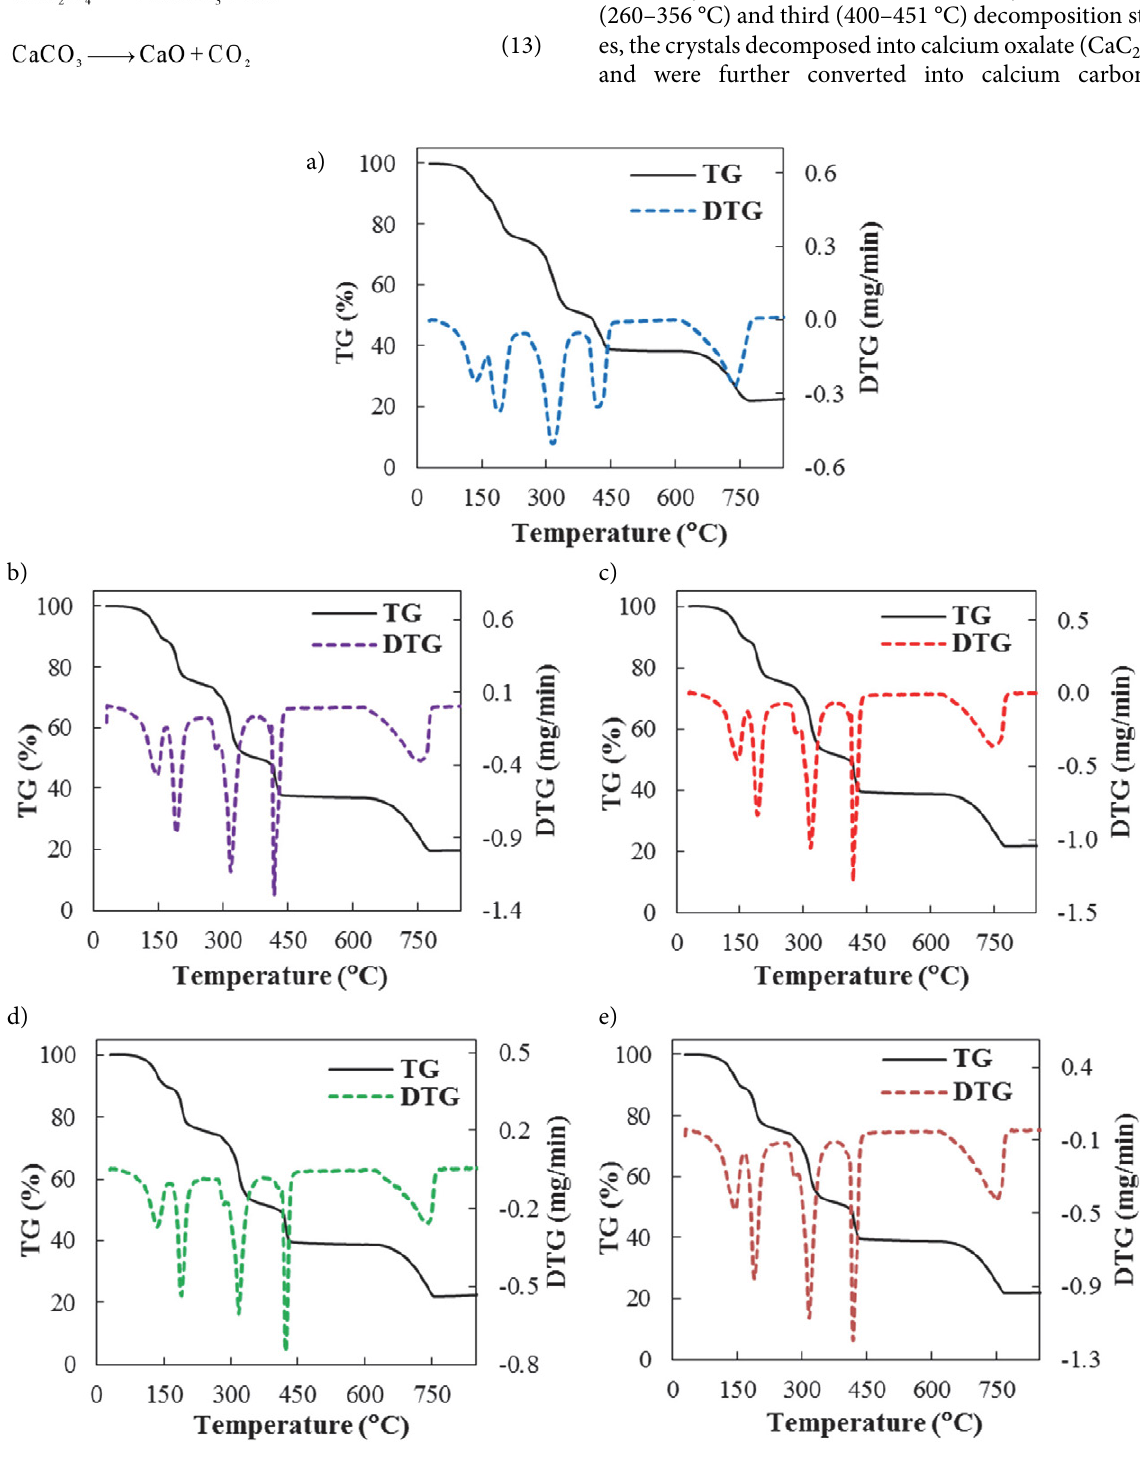
Figure 7. TG/DTG curves of the CTT crystals obtained in pure media (a) and media supplemented with serine (b), alanine (c), methionine (d), and proline